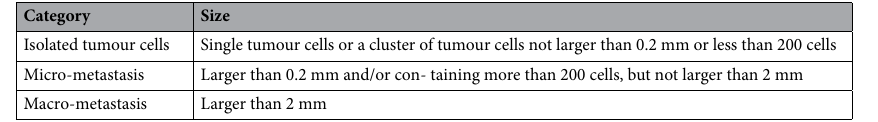
Table 2. Tumour size criteria for assigning metastasis type.